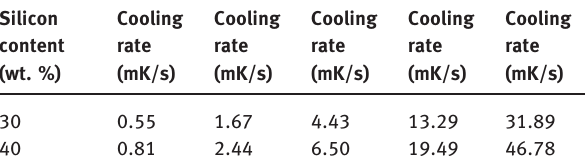
Table 2: The silicon contents and cooling rates of the samples. Silicon content